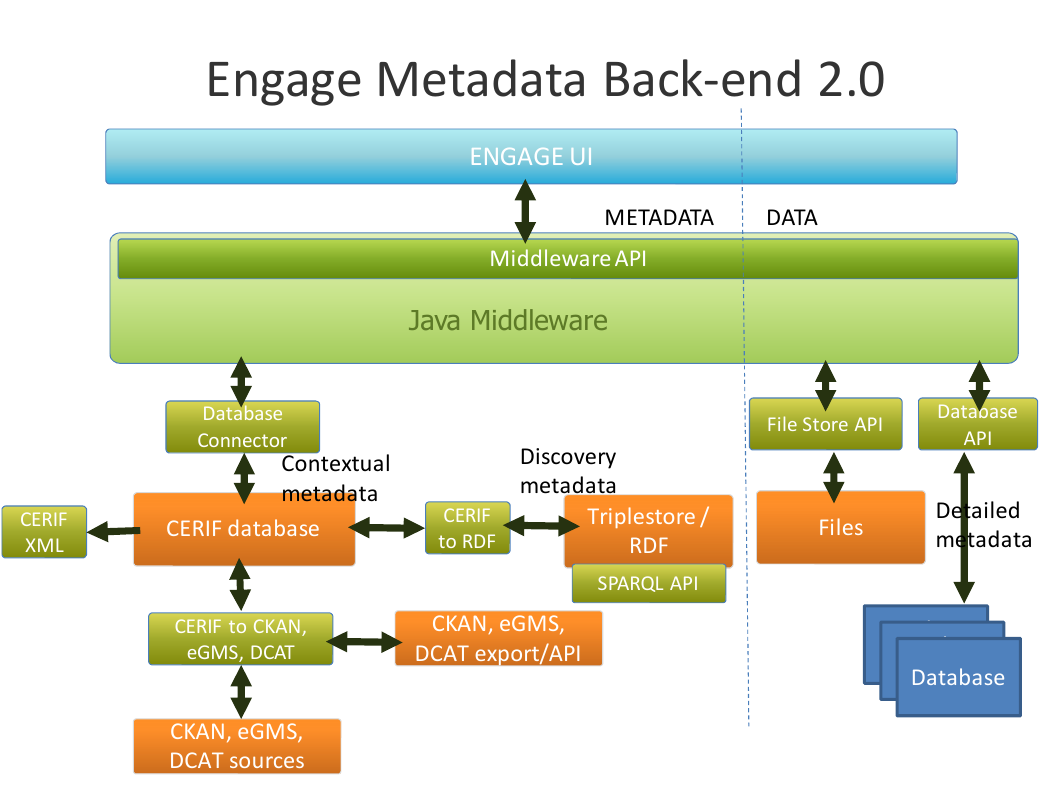
Figure 2. Concept of metadata architecture implementation in the ENGAGE infrastructure (EuroCRIS,